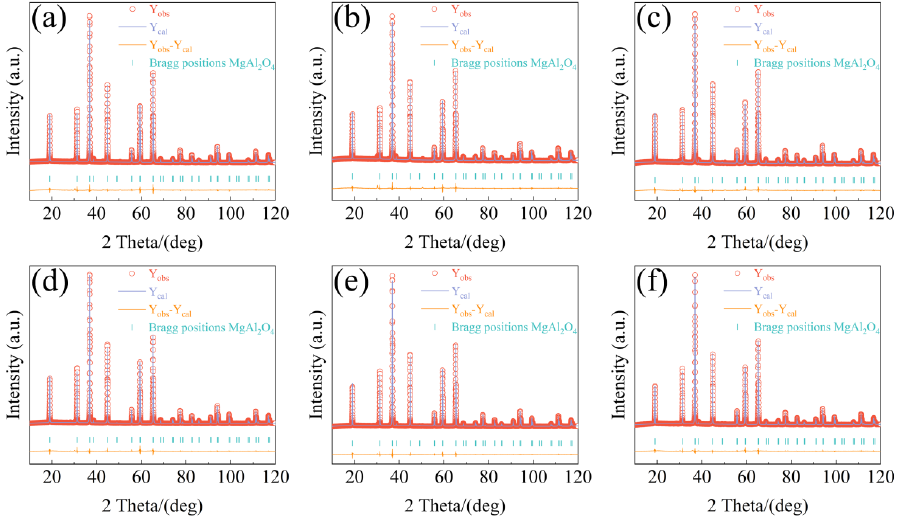
Figure 3. The XRD with Rietveld refinements: ( a ) x = 0, ( b ) x = 0.04, ( c ) x = 0.08, ( d ) x = 0.12, ( e ) x = 0.16, and ( f ) x = 0.20. Table 2. The cell parameters, density, and reliable factors were obtained based on the Rietveld refinements of XRD.